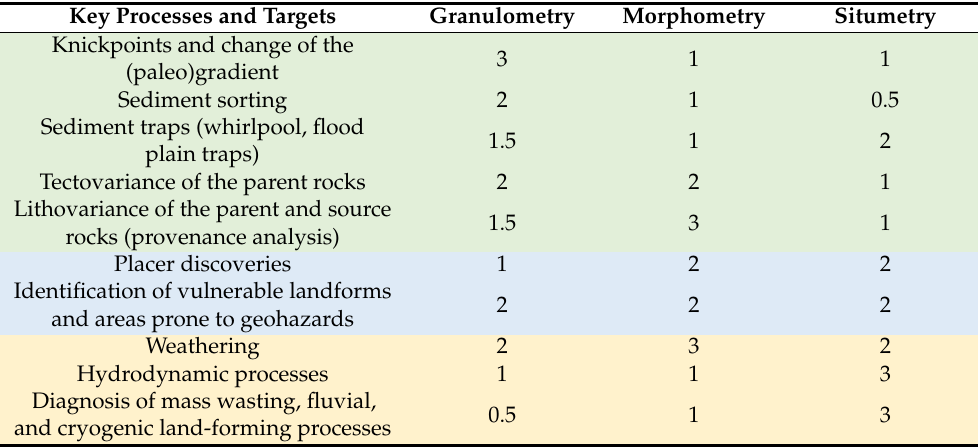
Table 3. The GMS tool and how it can be used in a basement-foreland transition zone. Objects (green). Methods of the E and E issue (economic geology and environmental geology). Identification of land-forming